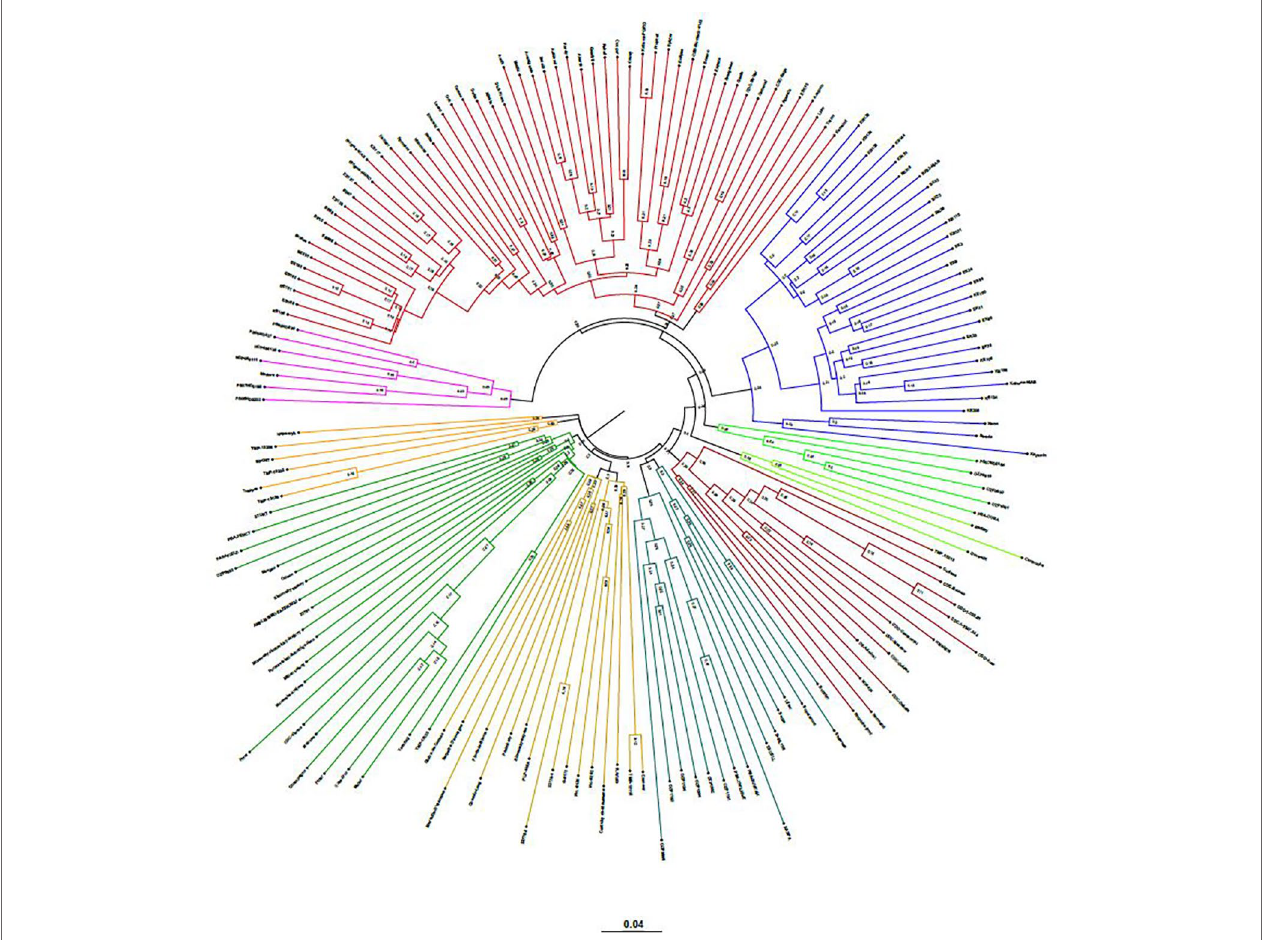
FiGUre 4 | Genetic relatedness among the 135 pea accessions estimated by neighbor-joining method and represented as a polar tree diagram. The estimated genetic relatedness is based on 16,877 SNPs identified by genotyping-by-sequencing and filtered for minor allele frequency of 0.05.